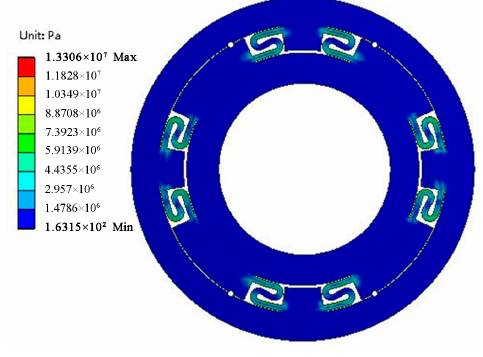
Figure 8. ISFBD stress contour.